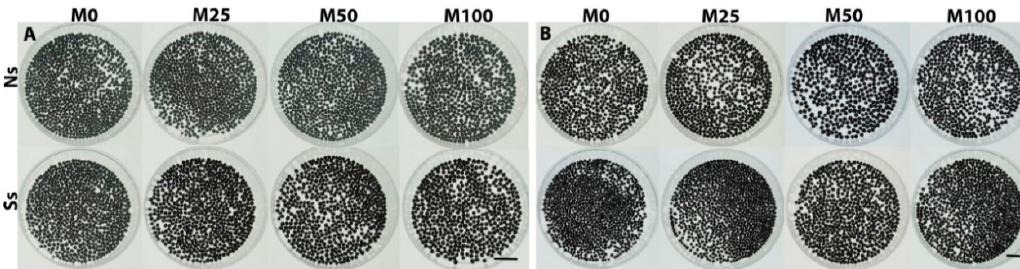
Figure 6. Photographs of two B. napus seeds affected by seed priming with 0 µM (M0), 25 µM (M25), 50 µM (M50), and 100 µM melatonin (M100) and salt stress (Ns: non-NaCl stress; Ss: 100 mM NaCl) using seed scanner. ( A ): Yangyoushuang2. ( B ): Xiangyouza553 cultivar. Bars = 1 cm.